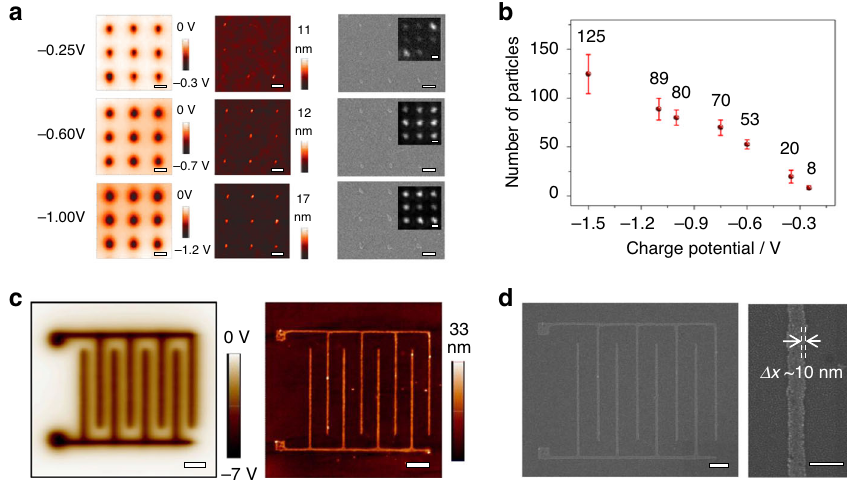
Fig. 4 Tunable pixel size and printed interdigitated nanoelectrodes. a Tuning the pixel size (the number of NPs on each spot) by adjusting the charge potential. From left to right, they are KPFM potential mapping, corresponding AFM height mapping, SEM, and PL images (inset) of CsPbBr 3 QD patterns. Scale bar, 500 nm. b The near-linear relationship between the average number of NPs on each spot and the charge potential. Error bars represent the standard deviation of the NPs numbers on 100 spots of each potential. c KPFM potential image and AFM height mapping of interdigitated nanoelectrode printed with 10-nm Au NPs. Scale bar, 1 μ m. d Corresponding SEM of the interdigitated nanoelectrode and an enlarged part, showing a fi nger width of 150 nm with variation less than 10 nm. Scale bar, 1 μ m (left), and 200 nm